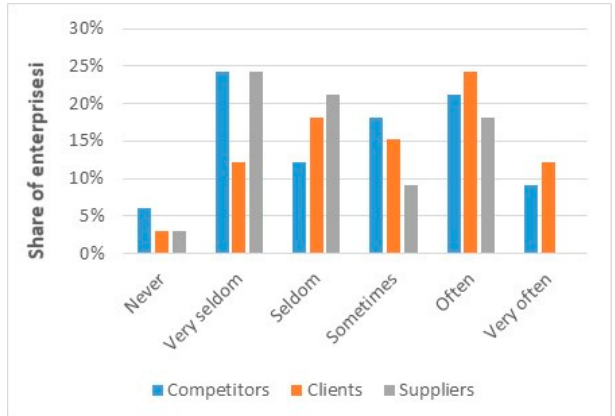
Figure 4. Drivers of innovation (part 2).